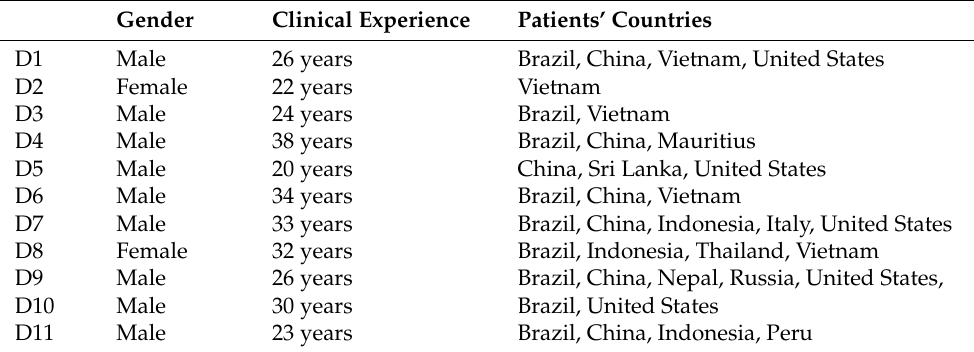
Table 1. Research